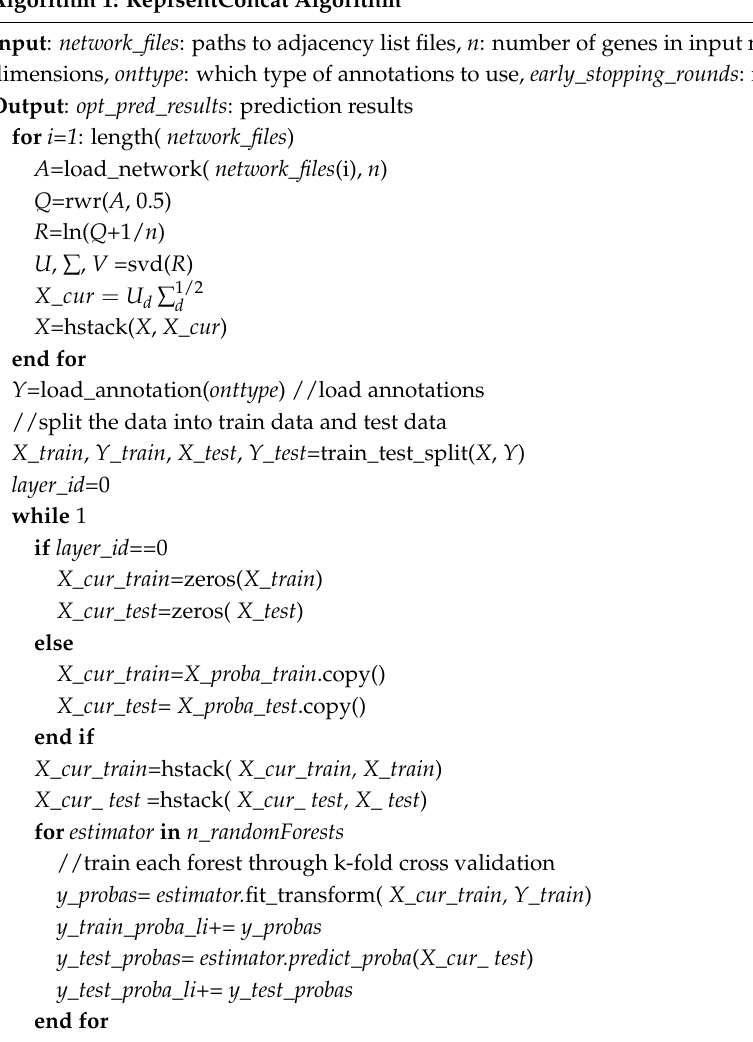
Algorithm 1: ReprsentConcat